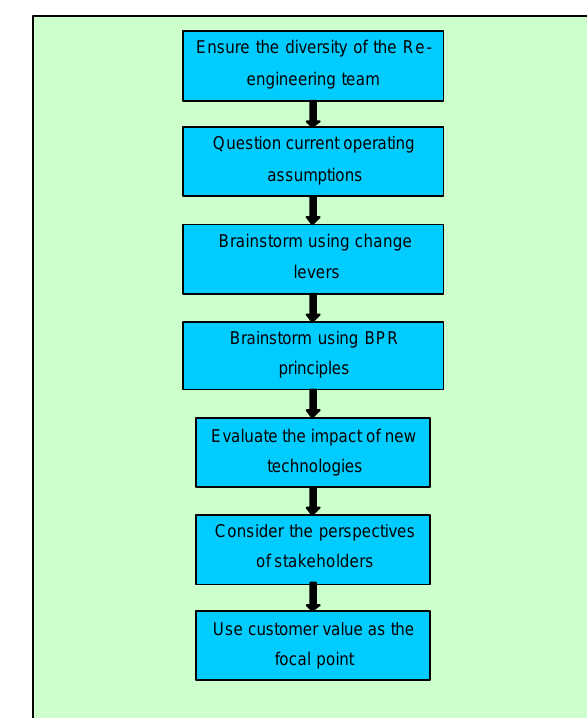
Figure 3: Activities Performed in Phase 3